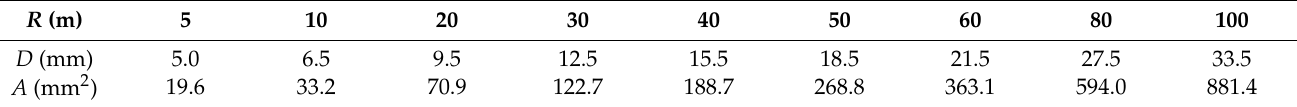
Table 3. Diameter and area of laser spots for Z+F IMAGER 5016.